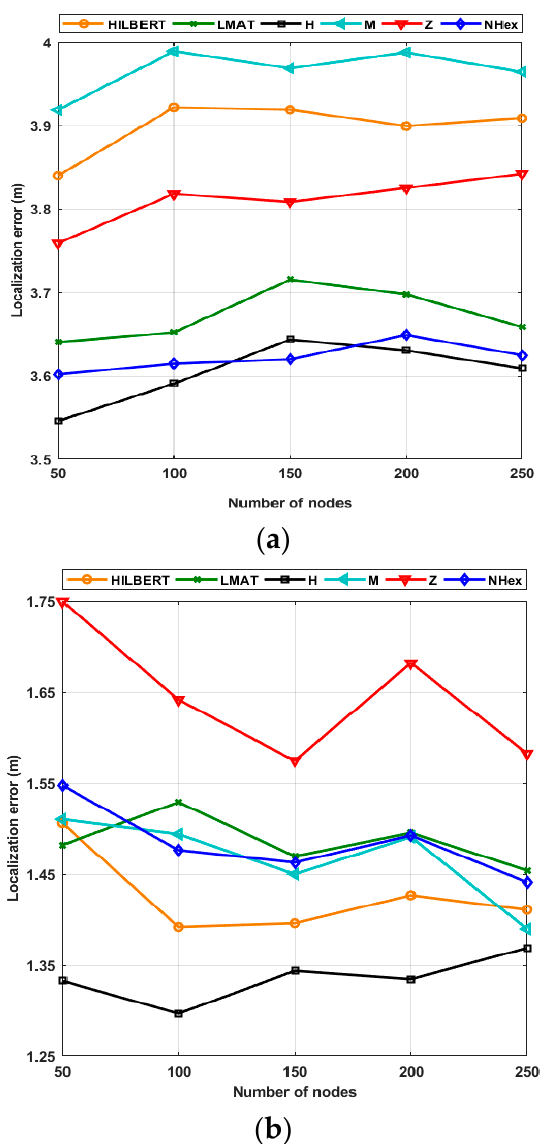
Figure 17. Scalability of the path planning models in terms of localization error performance ( a ) WCL, and ( b ) APT.